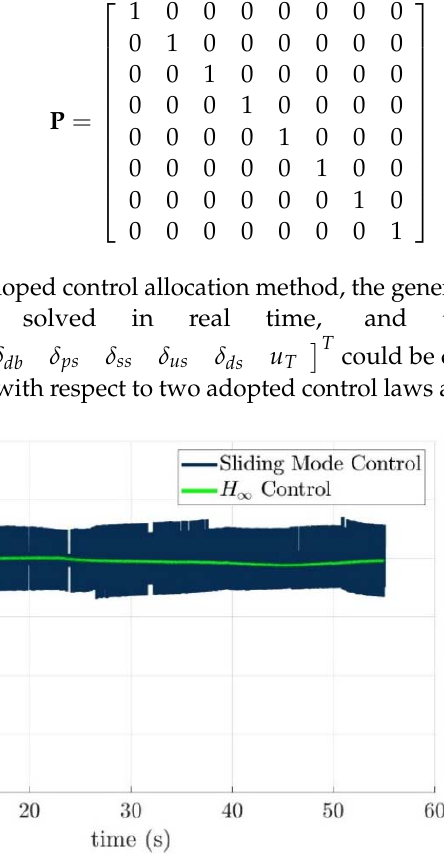
laws, respectively. laws,